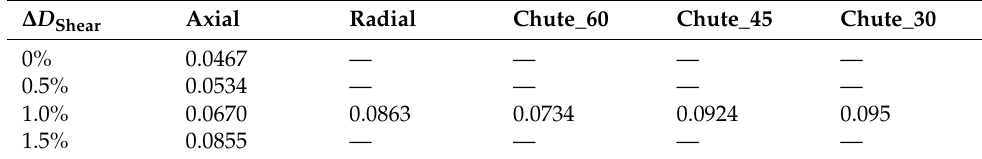
Table 5. Viscous shear loss (dm 3 ).